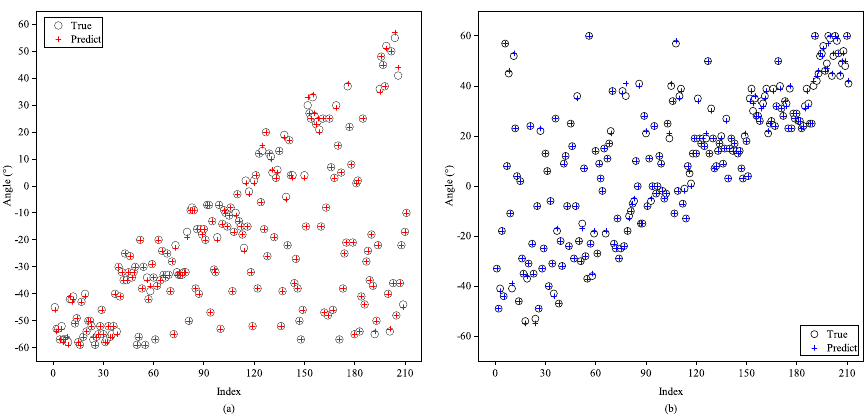
Figure 10. Testing of the proposed A-CRNN model to two-signal testing samples while trained in three-signal case: ( a ) the first signal and ( b ) the second